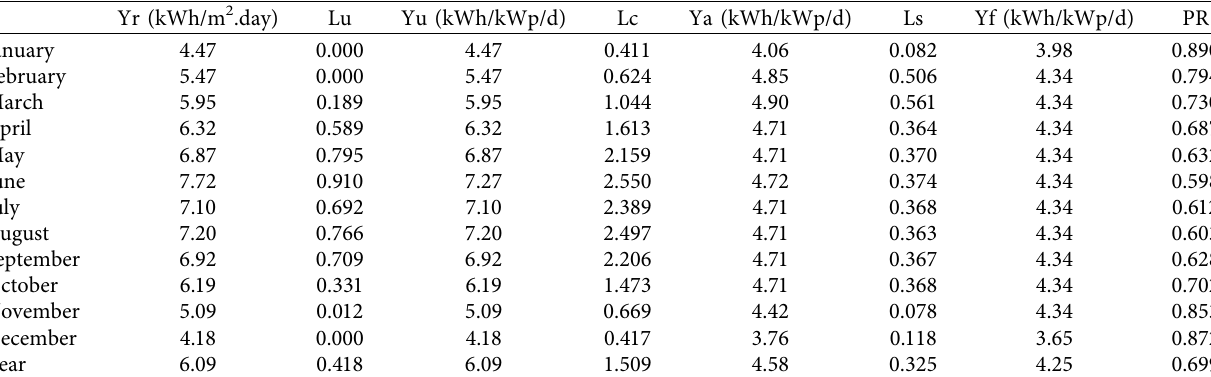
Table 3: Performance related to PV solar cells derived from the simulation system.